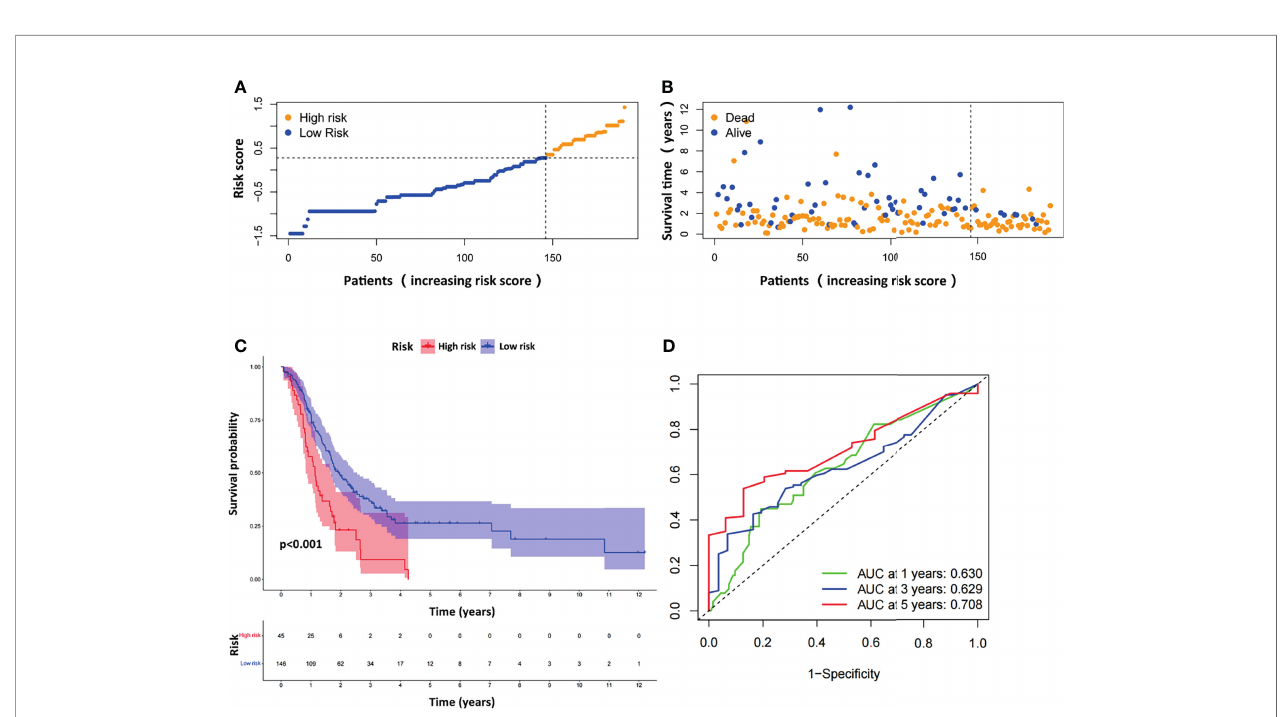
FIGURE 4 | Evaluation of the prognostic ARGPs in the GEO-merged cohort. (A) Distribution of risk scores of high- and low-risk PAAD patients based on the ARGPs-based prognostic signature. (B) The scatter plot showed the correlation between the survival status of high- and low-risk PAAD patients. (C) Kaplan-Meier analysis of the high-risk and low-risk groups of PAAD patients in the GEO-merged cohort. (D) ROC curves of the risk scores of PAAD patients in the GEO merged cohort at 1, 3, and 5 years. AUC, area under the receiver operating characteristic